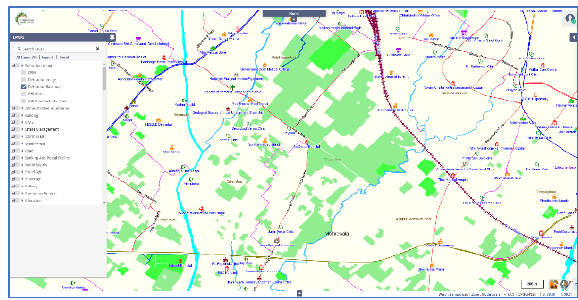
Figure_6: Surveyed Point Data and Road Network from Satellite Data N.B. All maps displayed here are Courtesy: Dehradun Smart City Limited